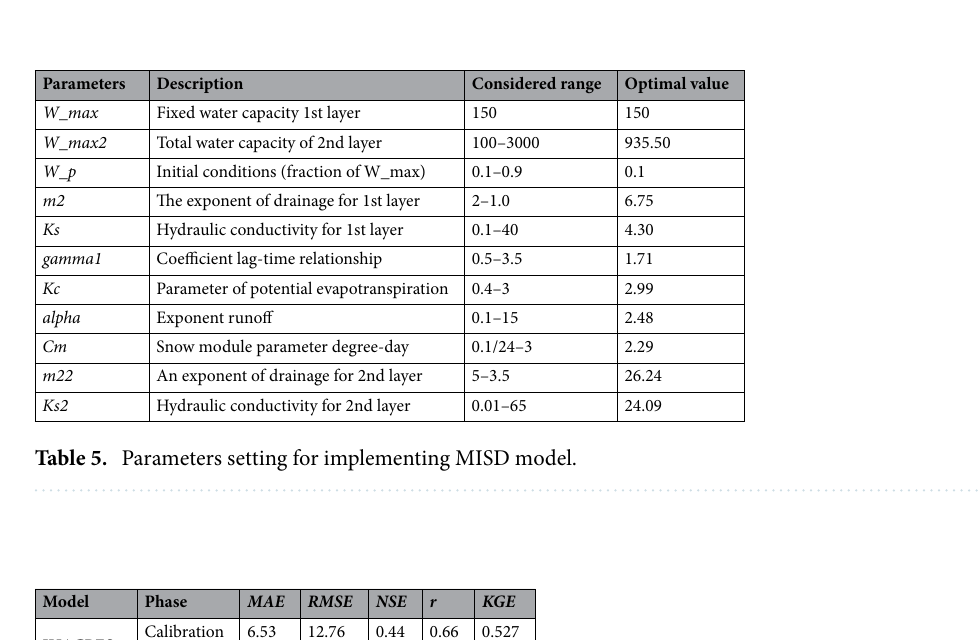
Table 4. Parameters setting by SCE-UA approach for IHACRES model.